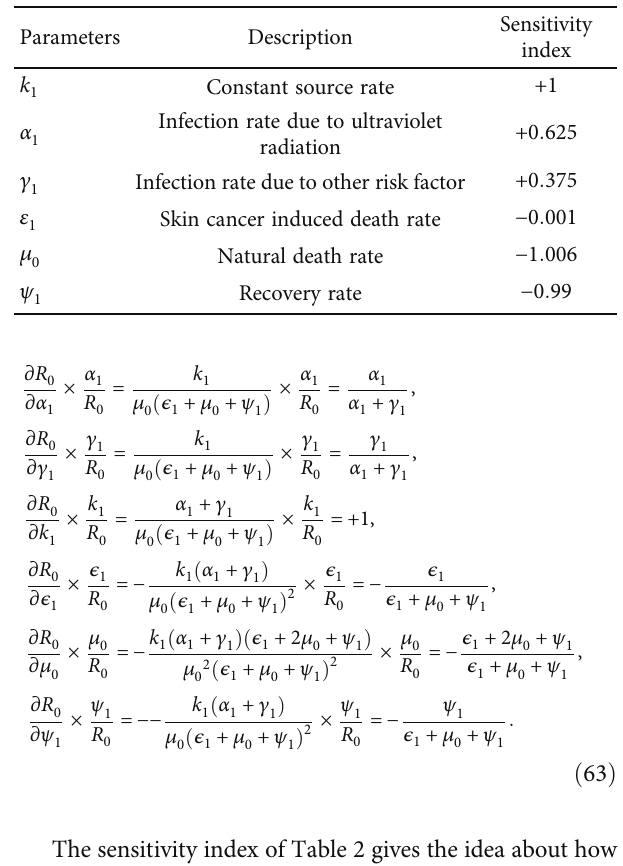
Figure 10: Yearly global cases of skin cancer incidence are represented by pink colored dash line and the cases from mathematical simulation are represented by green colored solid line. Table 2: Sensitivity indices of R 0 on parameters for system